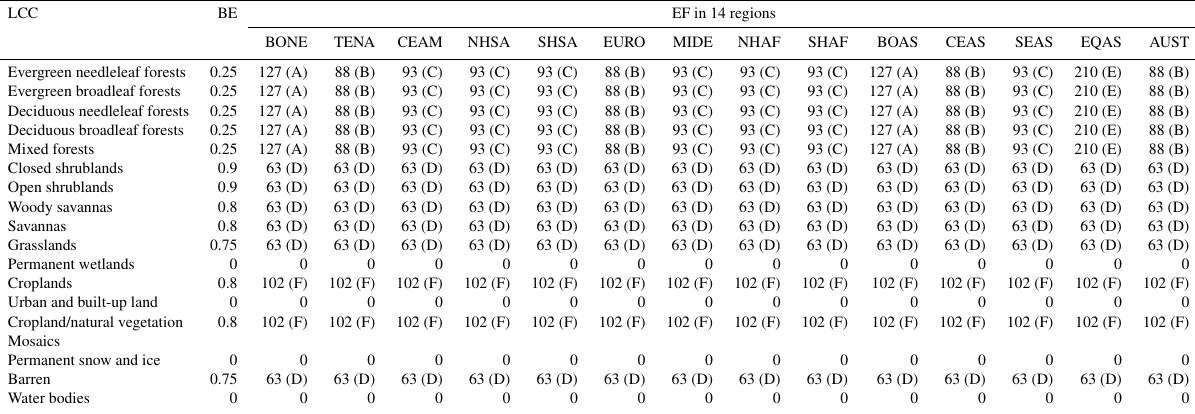
Table A2. As Table A1 but for the LCC types used in MCD12Q1. LCC BE EF in 14 regions BONE TENA CEAM NHSA SHSA BOAS Evergreen needleleaf forests 0.25 127 (A)